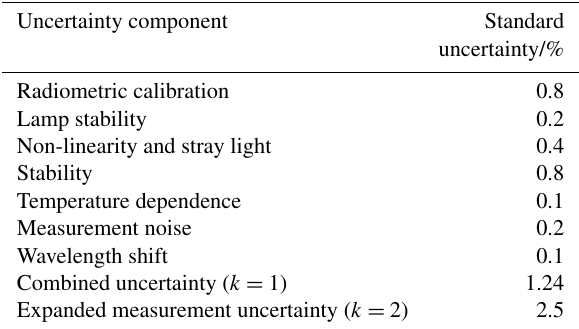
Table 1. Measurement uncertainties for the spectral irradiance mea-